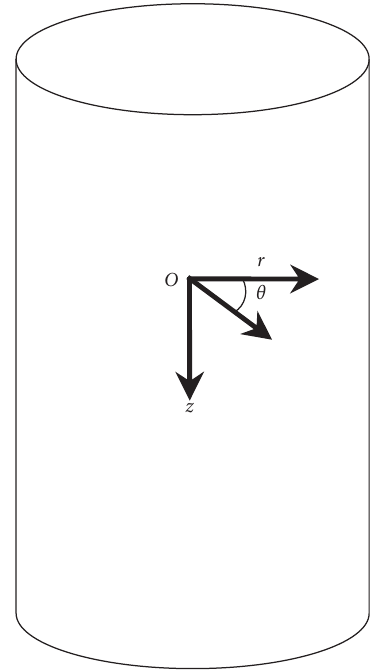
Figure 1: Uniaxial compression mechanics.